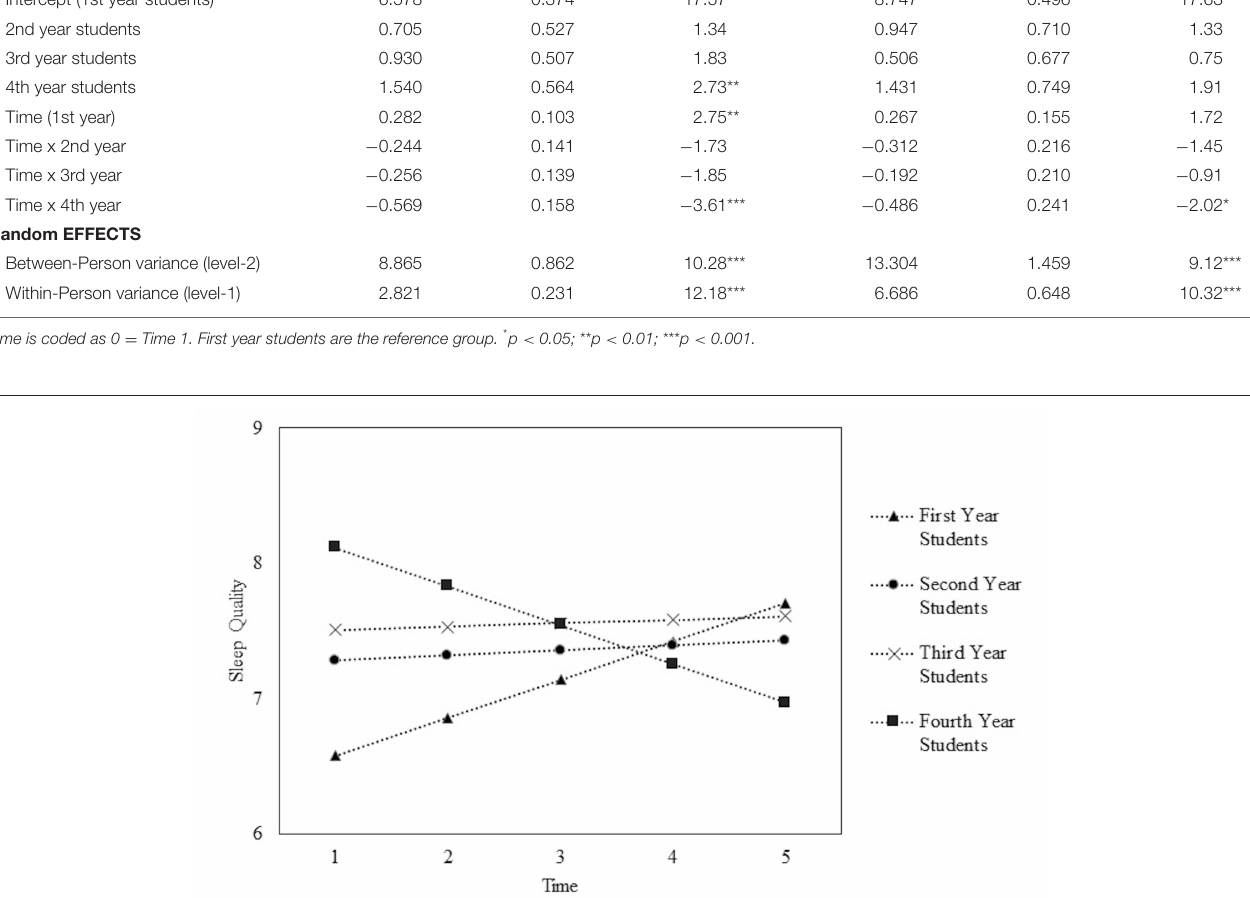
Frontiers in Veterinary Science |